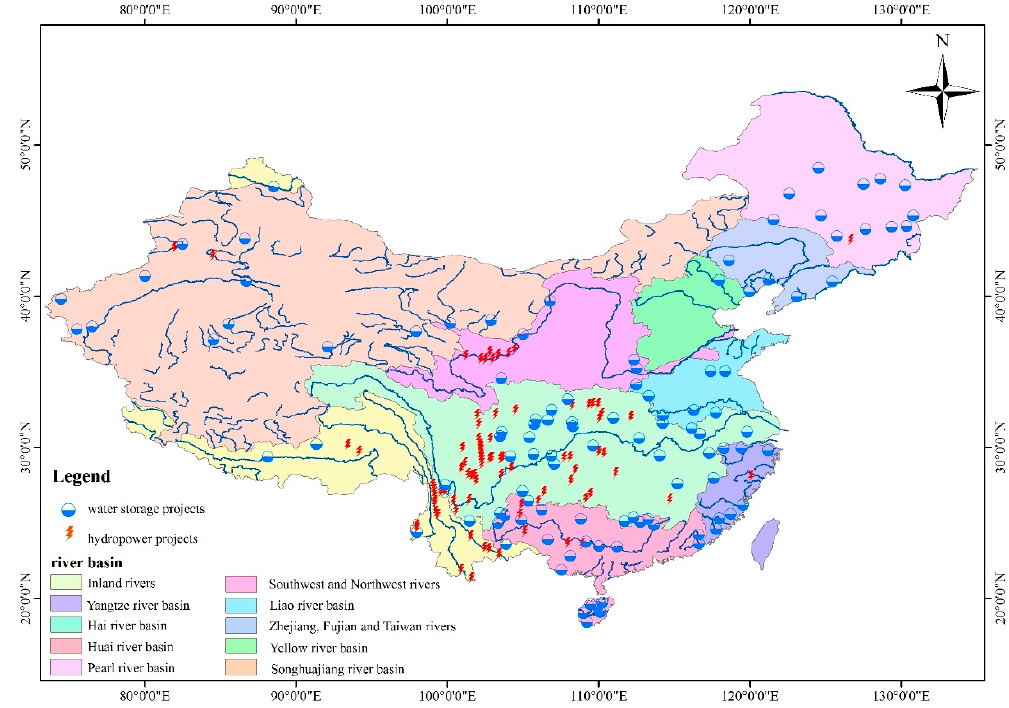
Figure 1. Locations of the water storage and hydropower projects.